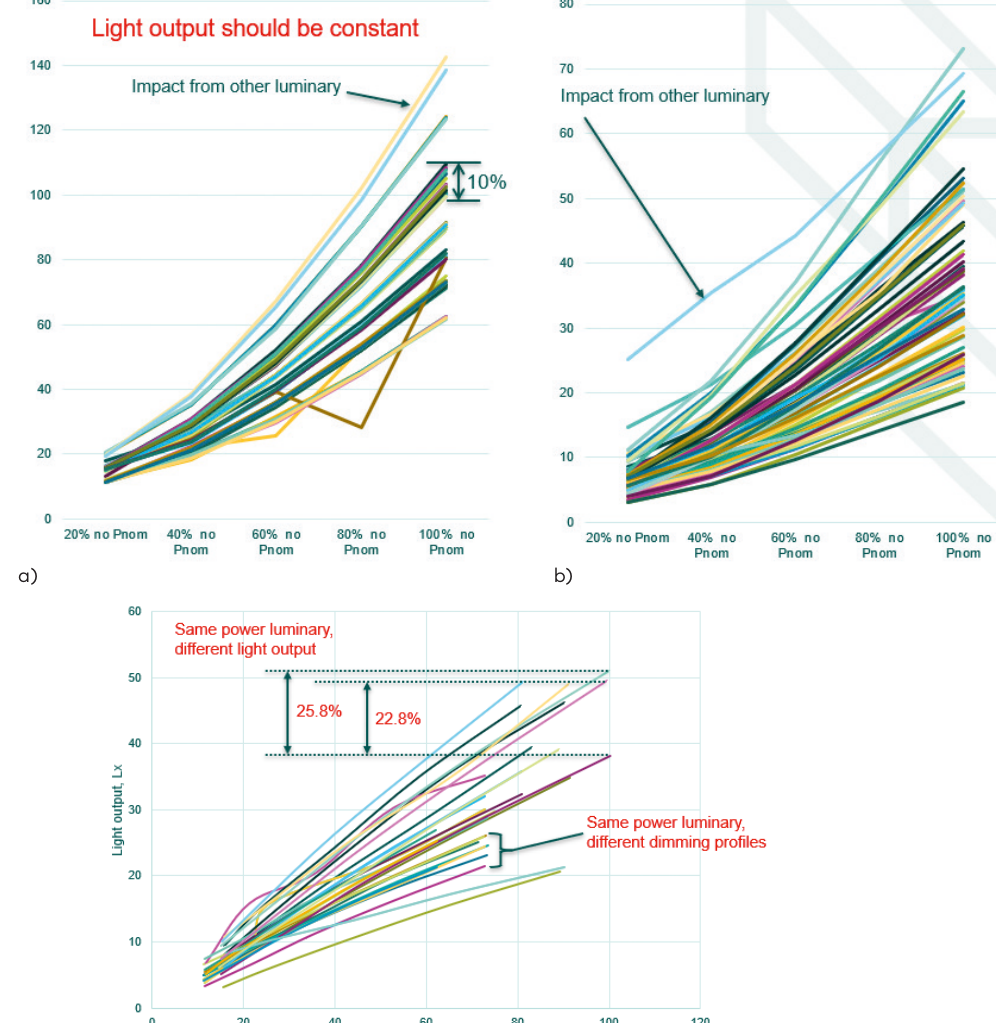
Figure 16. Graphical relation of power consumption, dimming value and measured light output